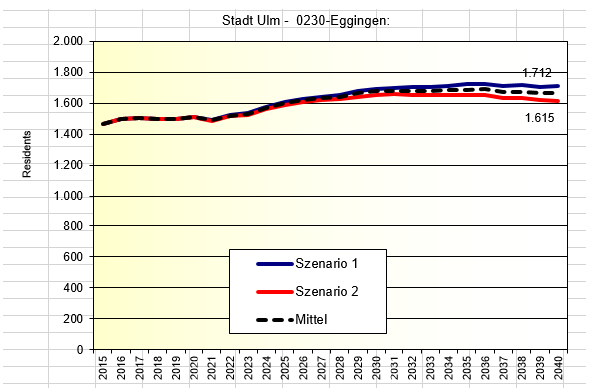
Figure 14 : Chart Showing the Prognosis Data (Municipality of Ulm)